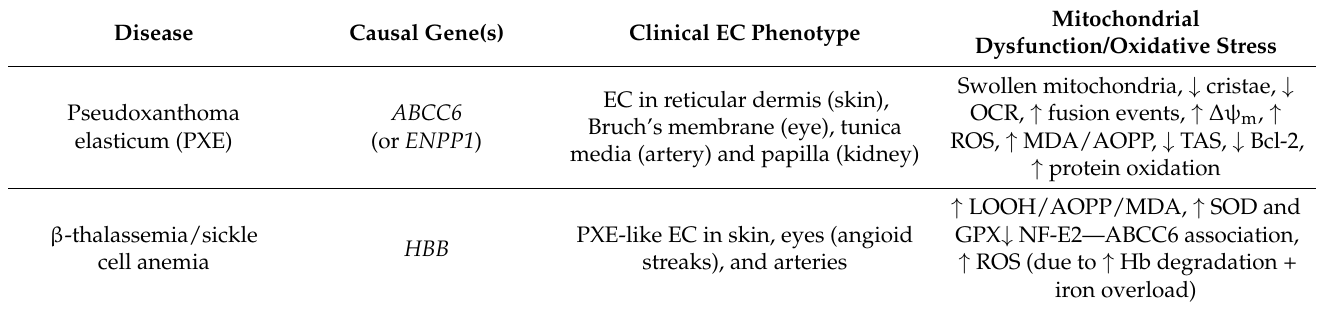
Table 1. Overview of hereditary ectopic calcification diseases with known mitochondrial dysfunction and/or oxidative